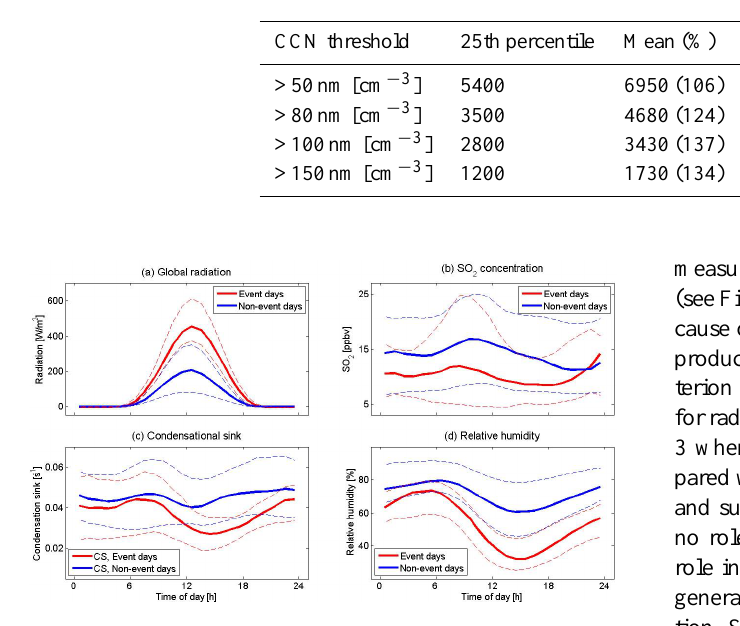
Table 7. Increase in CCN concentration during particle formation days. The number of particles above a certain size (CCN threshold in this table) was used as a CCN proxy. The percentages behind the mean and median values give the mean and, respectively, median increase in percent.